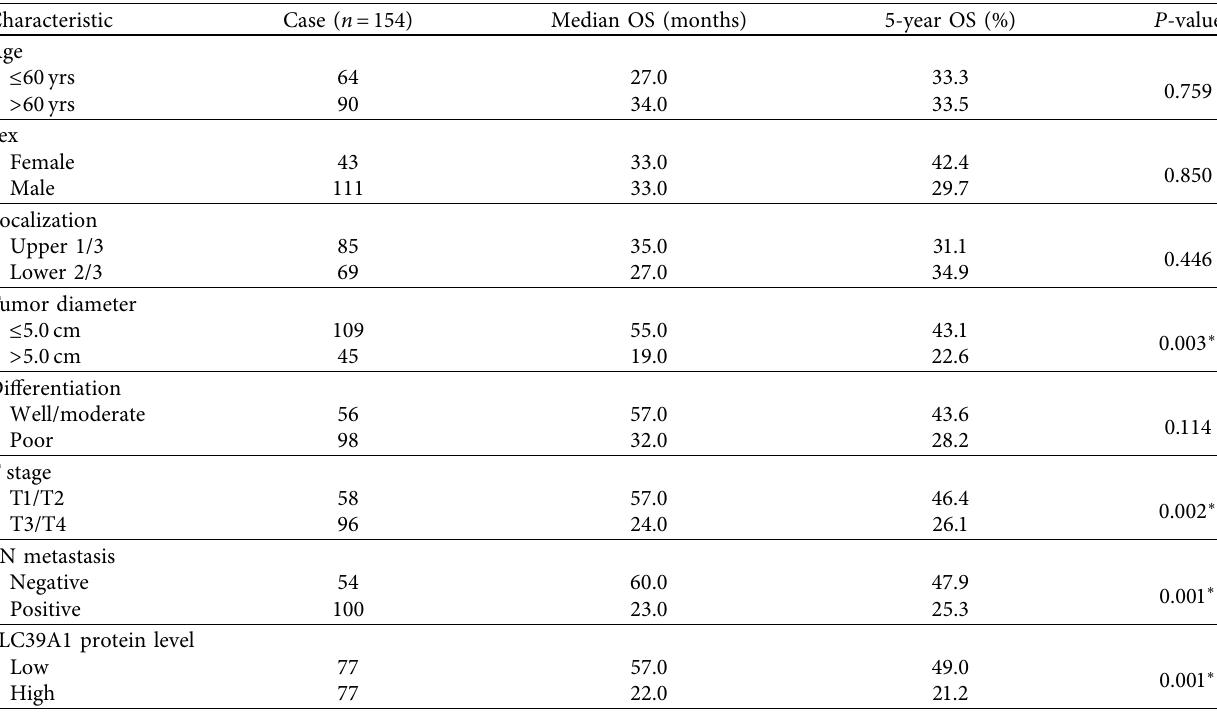
Figure 2: Overall survival curves of gastric adenocarcinoma patients in our retrospective cohort. Te survival curves were plotted using Kaplan–Meier method and compared using log-rank test based on SLC39A1 level (a), patients’ age (b), sex (c), tumor localization (d), tumor diameter (e), tumor diferentiation (f), T stage (g), and lymph node metastasis (h). ∗ indicates P < 0 . 05. Table 2: Kaplan–Meier overall survival (OS) analyses.